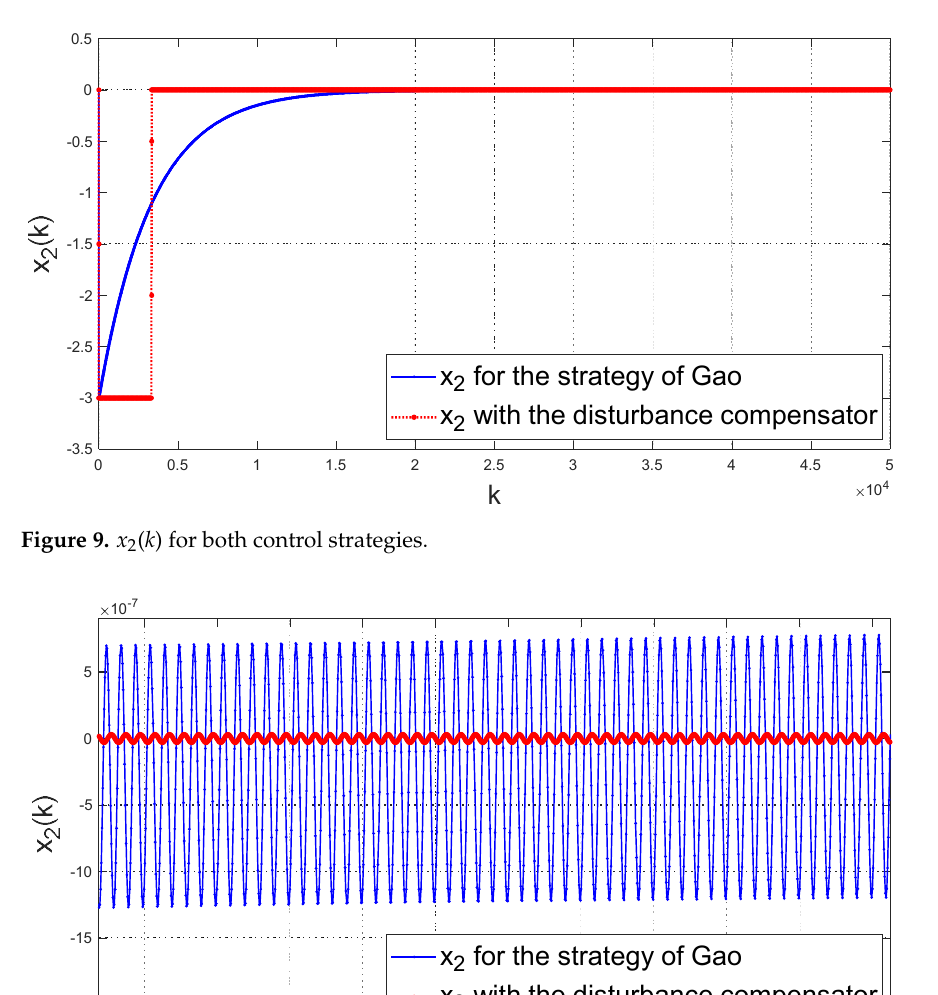
Figure 8. x 1 ( k ) for both control strategies in the sliding phase (zoomed).